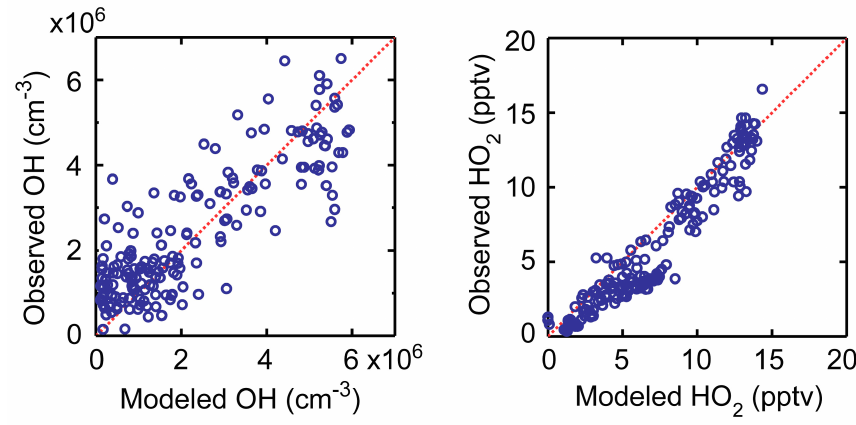
Fig. 9. Comparison of model results with observations of OH and HO 2 (for NO < 20pptv). CH 3 O 2 are dominated by the reactions of CO and CH 4 with OH,